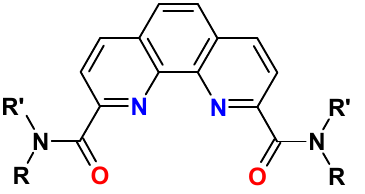
and UO 22+ ) [1] and unusually low affinity for Cu(II), Ni(II), Co(II), Zn(II), and Mg(II) [125].